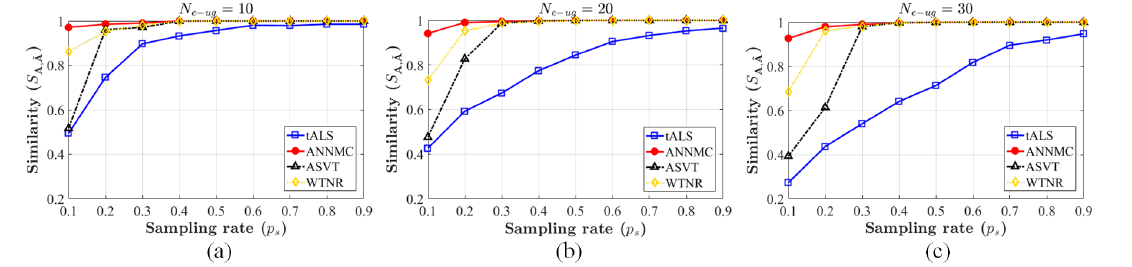
Figure 4. Comparison of similarity by different preference inferring algorithms (tALS, ASVT, WTNR and ANNMC) on the synthetic dataset. The number of blocks N e − ug = 10 corresponding to ( a ), 20 corresponding to ( b ) and 30 corresponding to ( c ). The range of the non-uniform sampling-rate p s is varied from 0.1 to 0.9 and the content types I = 15.